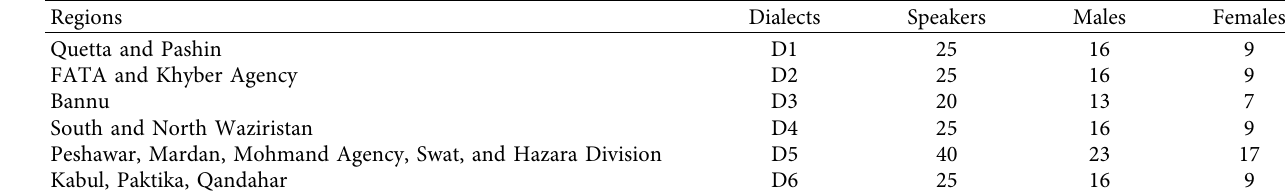
Table 3: Selected dialects with their respective regions of use.